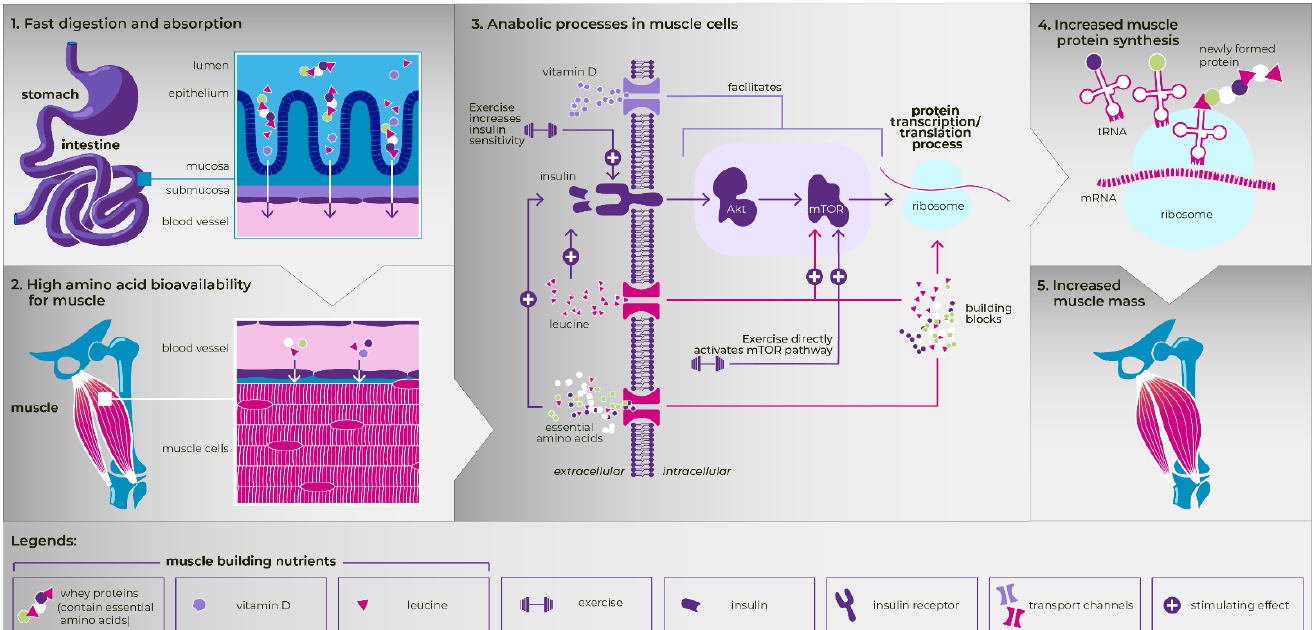
Figure 2. The effect of muscle-targeted ONS (whey protein, leucine and vitamin D) in combination with exercise in increasing appendicular muscle mass in older adults with sarcopenia (the present figure is used with permission from Danone Nutricia Research BV for this single publication).